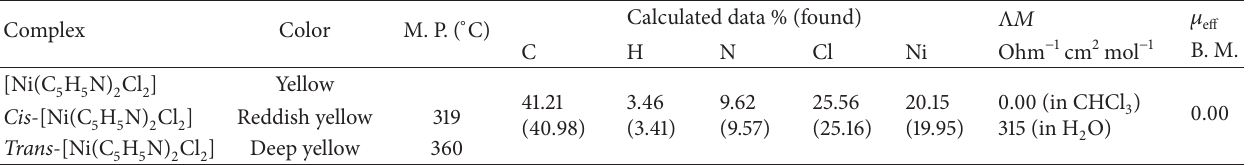
Table 1: Analytical and physical data for the